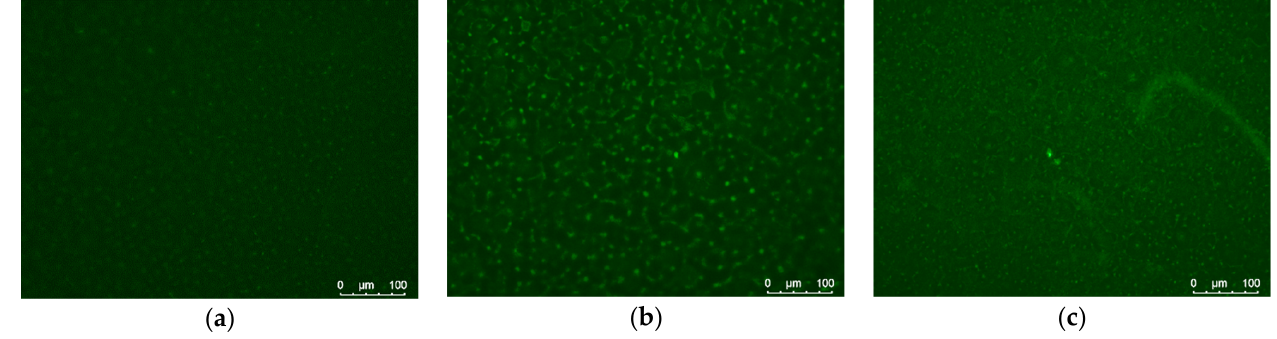
Figure 5. Fluorescent microscopy of FITC ‐ labeled collagen ‐ coated PLA films: ( a ) PLA ‐ S ‐ col, ( b ) PLA ‐ C ‐ col, ( c ) PLA ‐ A ‐ col.